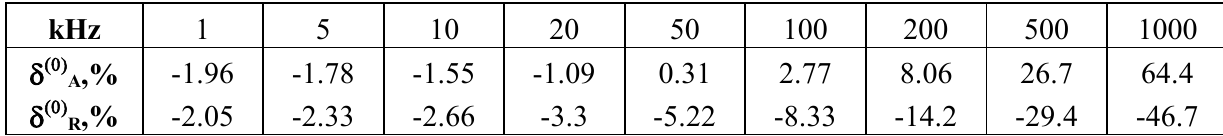
Table 1. Relative errors of measurement of active and reactive components without